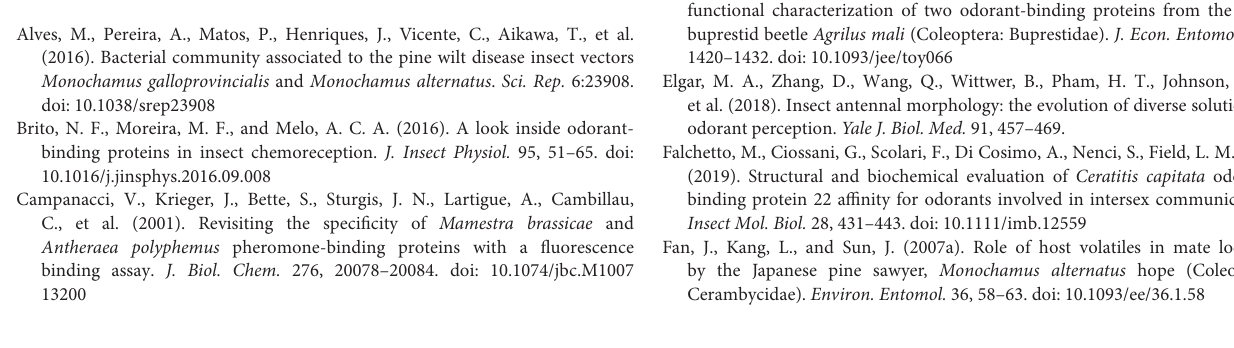
FIGURE S1 | MaltOBP1 antiserum titer tested by ELISA. FIGURE S2 | Nucleotide and deduced amino acid sequences of MaltOBP1. The predicted signal peptide at the N-terminus is underlined, the four conserved cysteines are boxed, and the stop codon is indicated with an asterisk. FIGURE S3 | Sequence alignment of 12 homologous Minus-C OBPs. The letters in the frame represent four conserved cysteines in the Minus-C OBP. Malt_OBP1 ( Monochamus alternates ): ABR53888.1; Malt_OBP12: AIX97027.1; Malt_OBP22: AIX97037.1; Malt_OBP23: AIX97038.1; Achi_OBP ( Anoplophora chinensis ): AUF72967.1; Agla_OBP1 ( Anoplophora glabripennis ): ATG83411.1; Agla_OBP72: XP_018563348.1; Agla_OBP83a: XP_018563349.1; Bhor_OBP2 ( Batocera horsfieldi ):; Ldec_OBP83a ( Leptinotarsa decemlineata ): XP_023027761.1; Rfer_OBP10 ( Rhynchophorus ferrugineus ): ANE37554.1; Rfer_OBP107: